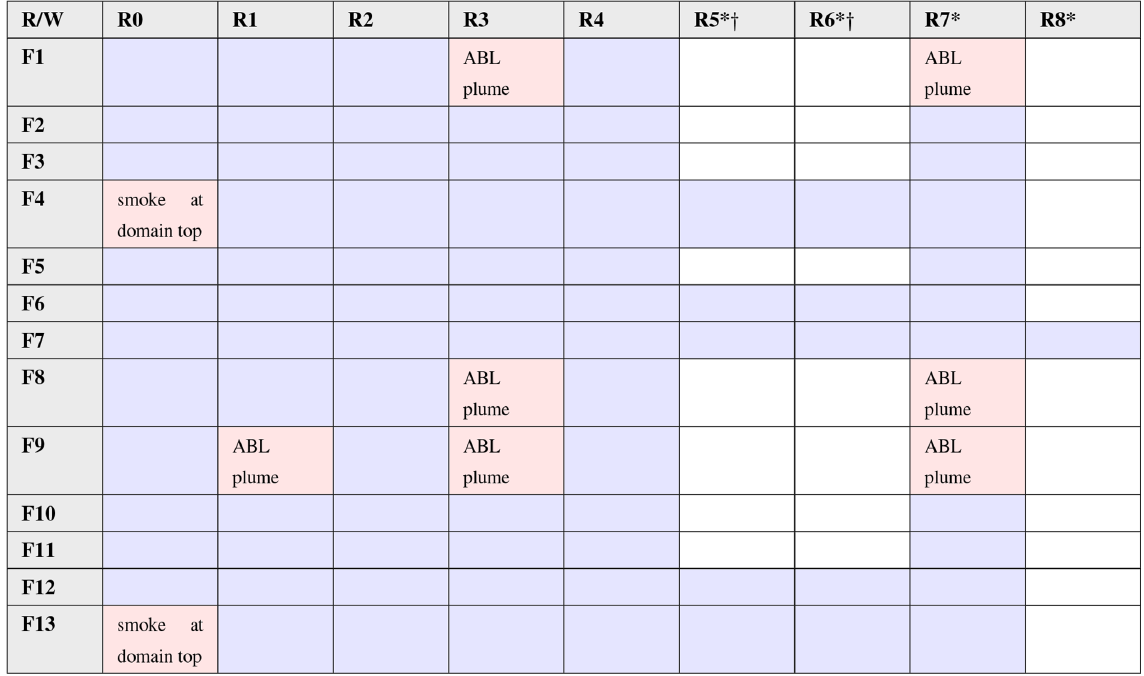
Table B2. Tested combinations of fuel and ABL conditions (all blue and pink colored